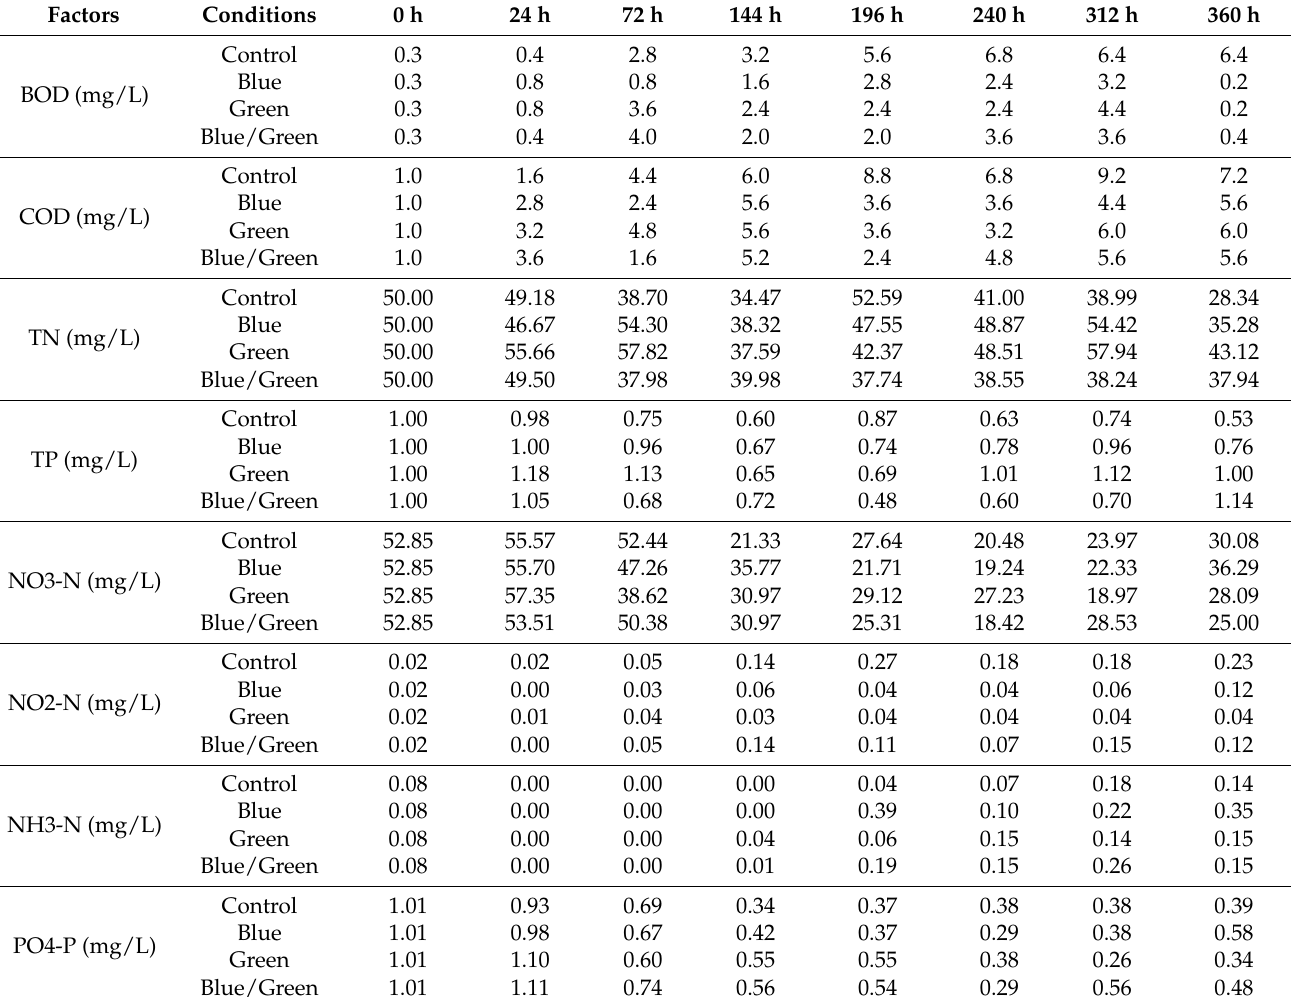
Table 1. The variation in water quality in cyanobacterial culture in each experimental group (Control: No intervention, Blue: blue film, Green: green film, Blue/Green: blue and green film).